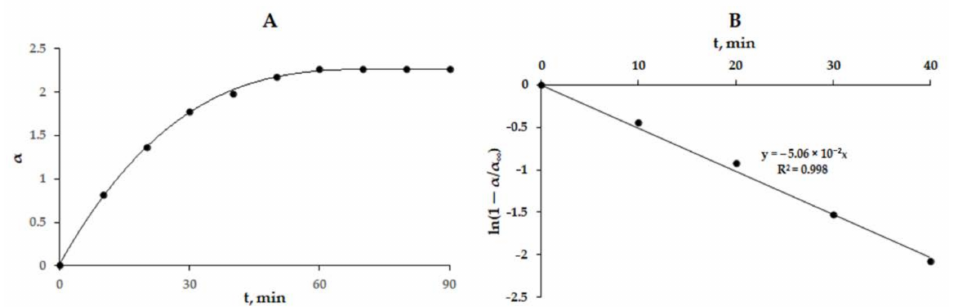
Figure 6. Kinetic curves of swelling of the crosslinked polymer in water in coordinates: ( A )—“vs. t” (cid:104) (cid:105) ( B )—“ ln 1 − α vs.t ” (the cross-linked copolymer was synthesized at the molar ratio VP/GMA in α ∞ the reaction system